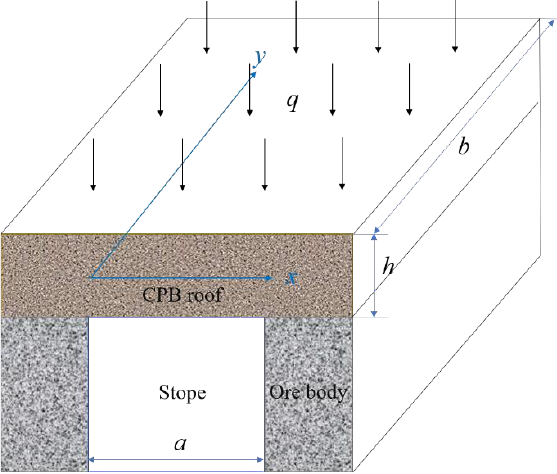
Figure 6. Mechanical model of CPB roof.